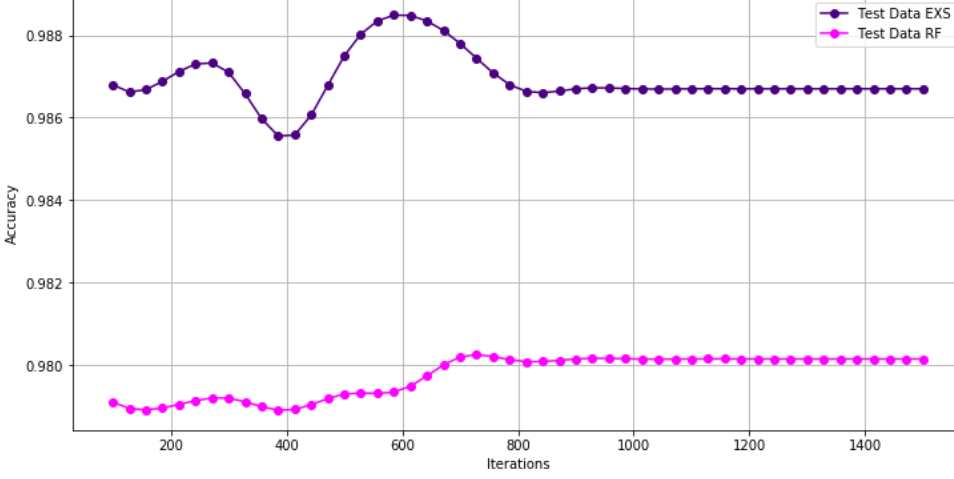
Figure 14. Example of the obtained validation curves.